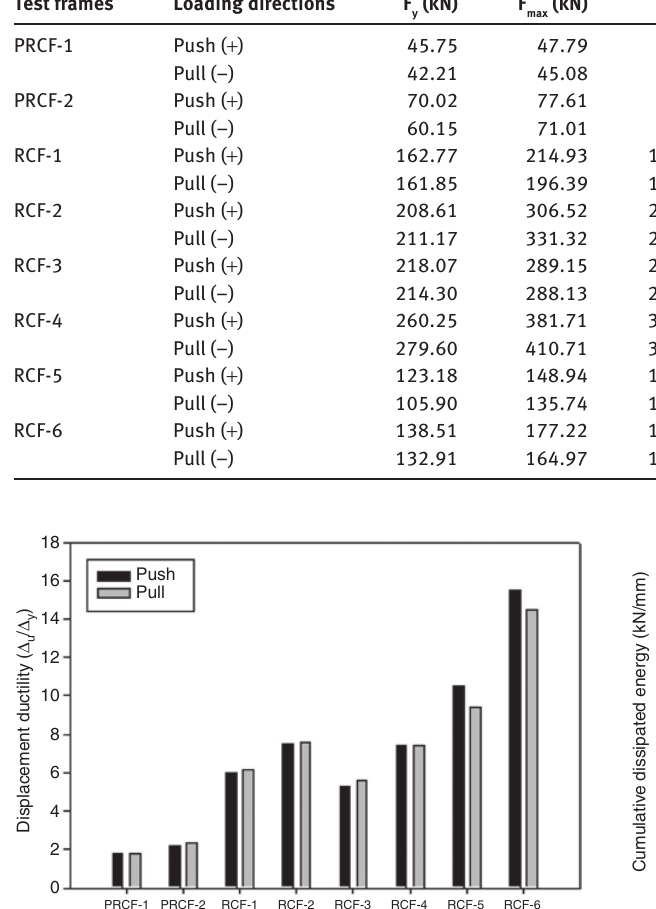
Table 6: Displacements at yield and ultimate loads and displacement ductility of the test frames. Test frames